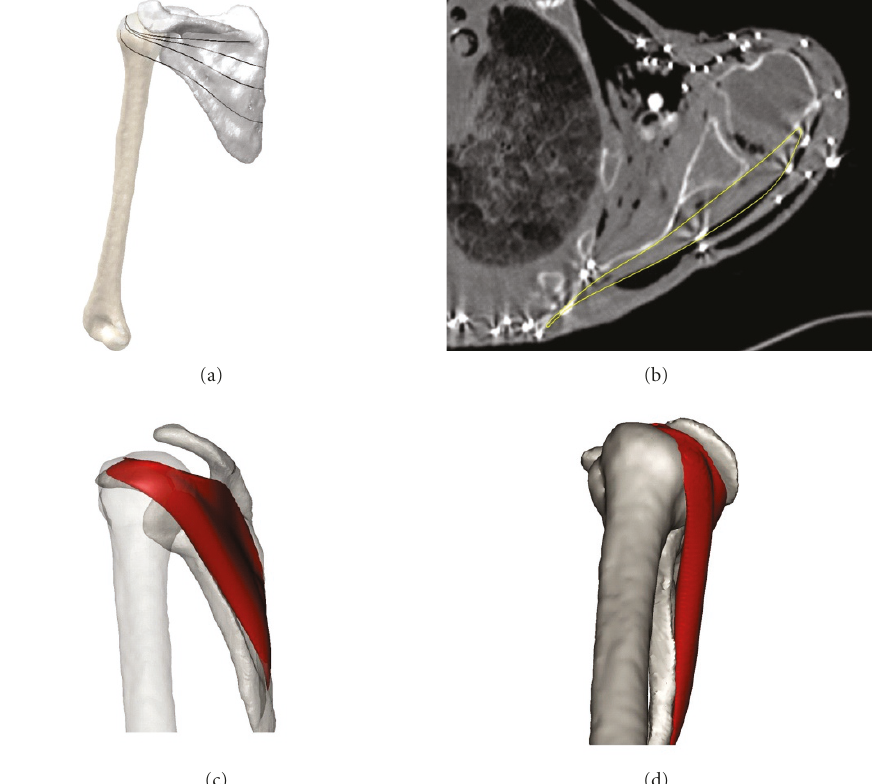
Figure 6: (a) Reconstruction of muscle fibre paths on the inner surface of the infraspinatus muscle. (b) Contour of the infraspinatus volume on the axial view. (c) & (d) Volumetric mesh of the infraspinatus muscle.